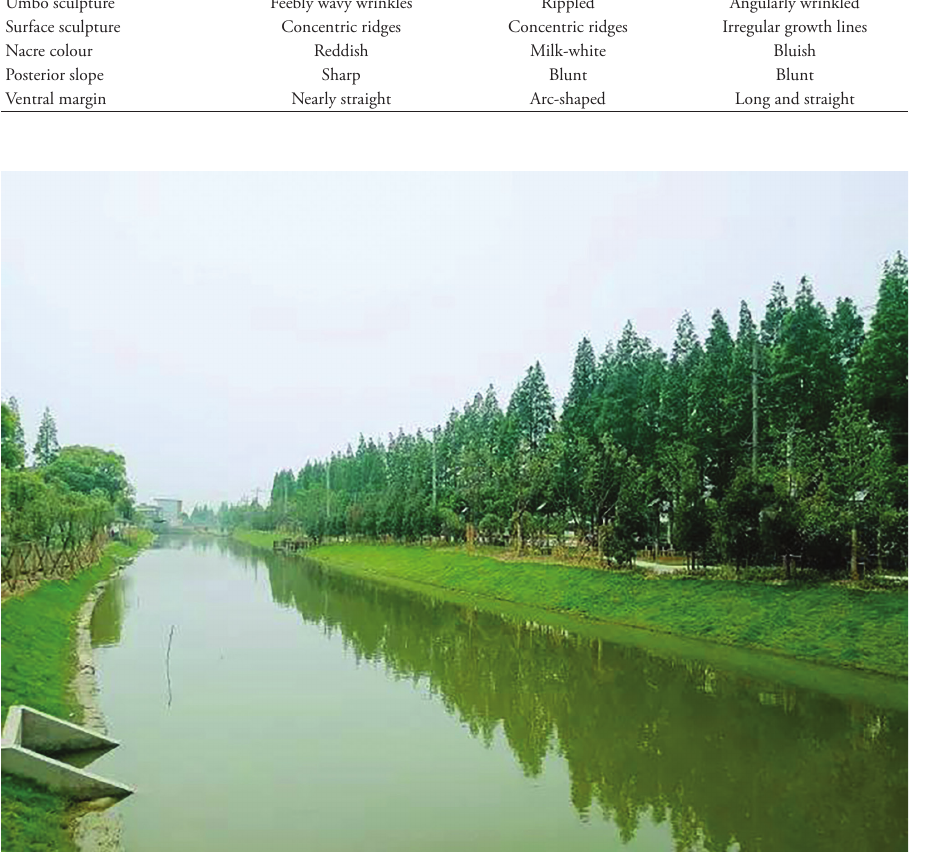
sister-group relationship with Inversidens brandtii (PP = 1.00, BS = 100; Fig. 3). The genera Pronodularia and Inversiunio belong to different clades well-separated from Inversidens (Fig.